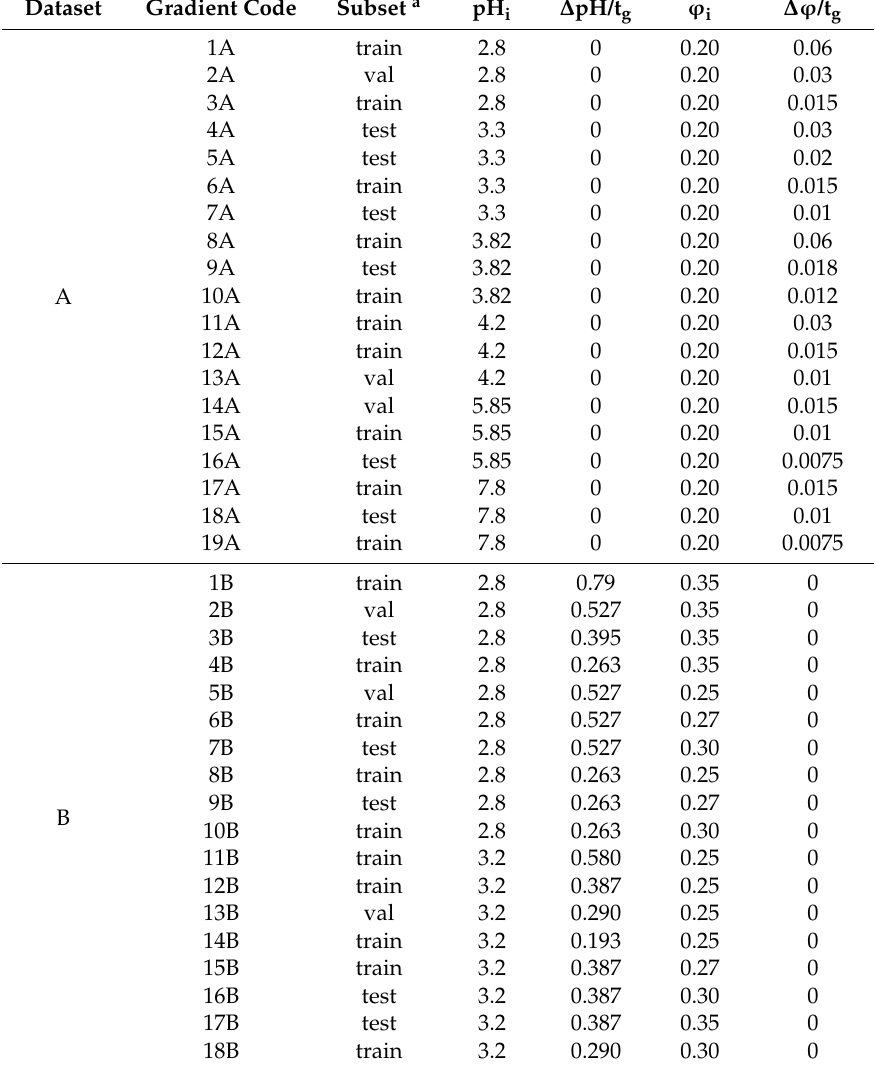
Table 1. Descriptors of the linear ϕ gradients (dataset A) and pH gradients (dataset B).